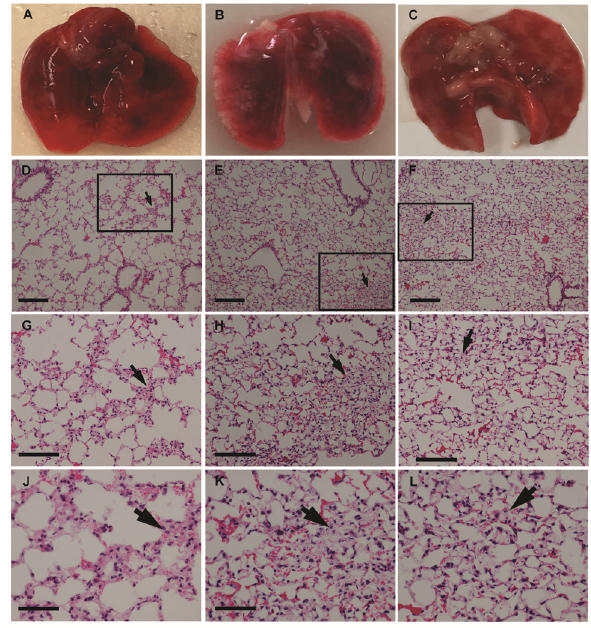
Figure 3. Gross appearance and histology of the lungs of SCID mice injected with H3122 human lung adenocarcinoma cells via the tail vein. (A-C) lungs from mice injected with cells at 3 (A), 5 (B), and 8 (C) weeks after cell injection. Note the white patches on the lungs, which appeared by week 5; D-F. Haematoxylin and Eosin stain of lungs from mice at 3 (D), 5 (E), and 8 (F) weeks after cell injection using a 10x objective. Squares and arrows indicate areas of high cell density; (G-I) Area shown in insets from panels (D-F) respectively, using a 20x objective. (J-L) Area shown in insets from images (D-F), respectively, using a 40x objective. Scale bars: D-I 100 µm; J-L 50 µm.